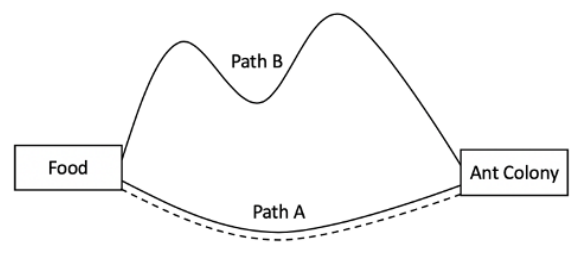
Figure 4. Path finding behavior of ants searching for